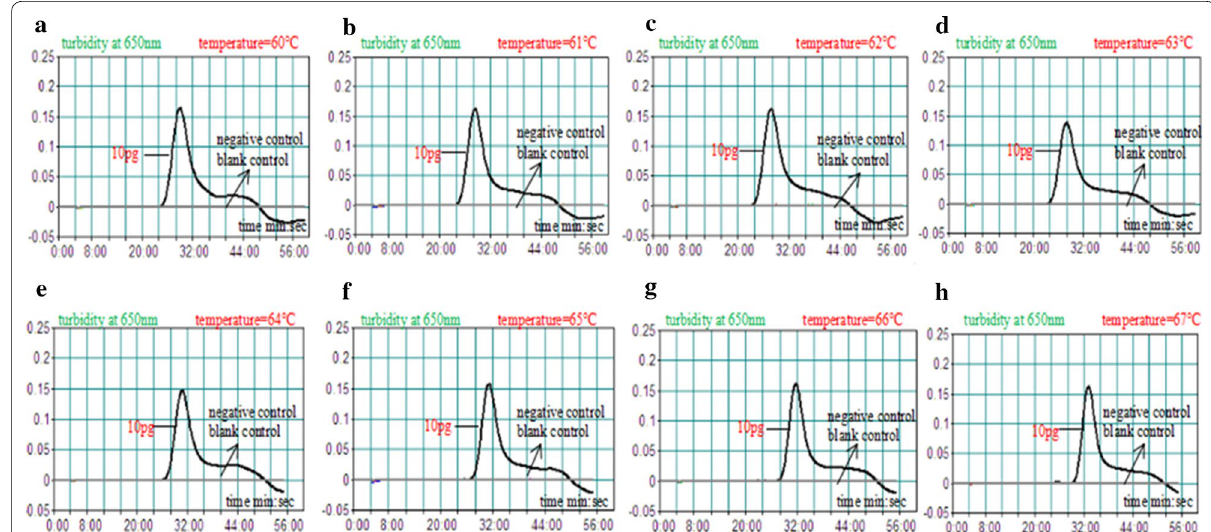
Fig. 3 Optimization amplification temperature for A. baumannii -MCDA primers. MCDA reactions for detection of A. baumannii were monitored by real-time measurement of turbidity and the corresponding curves of DNA concentration were marked in the diagram. Turbidity of > 0.1 was considered positive. Kinetic curves ( a – h ) were generated at 60–67 °C (1 °C intervals) respectively with 1 pg DNA per